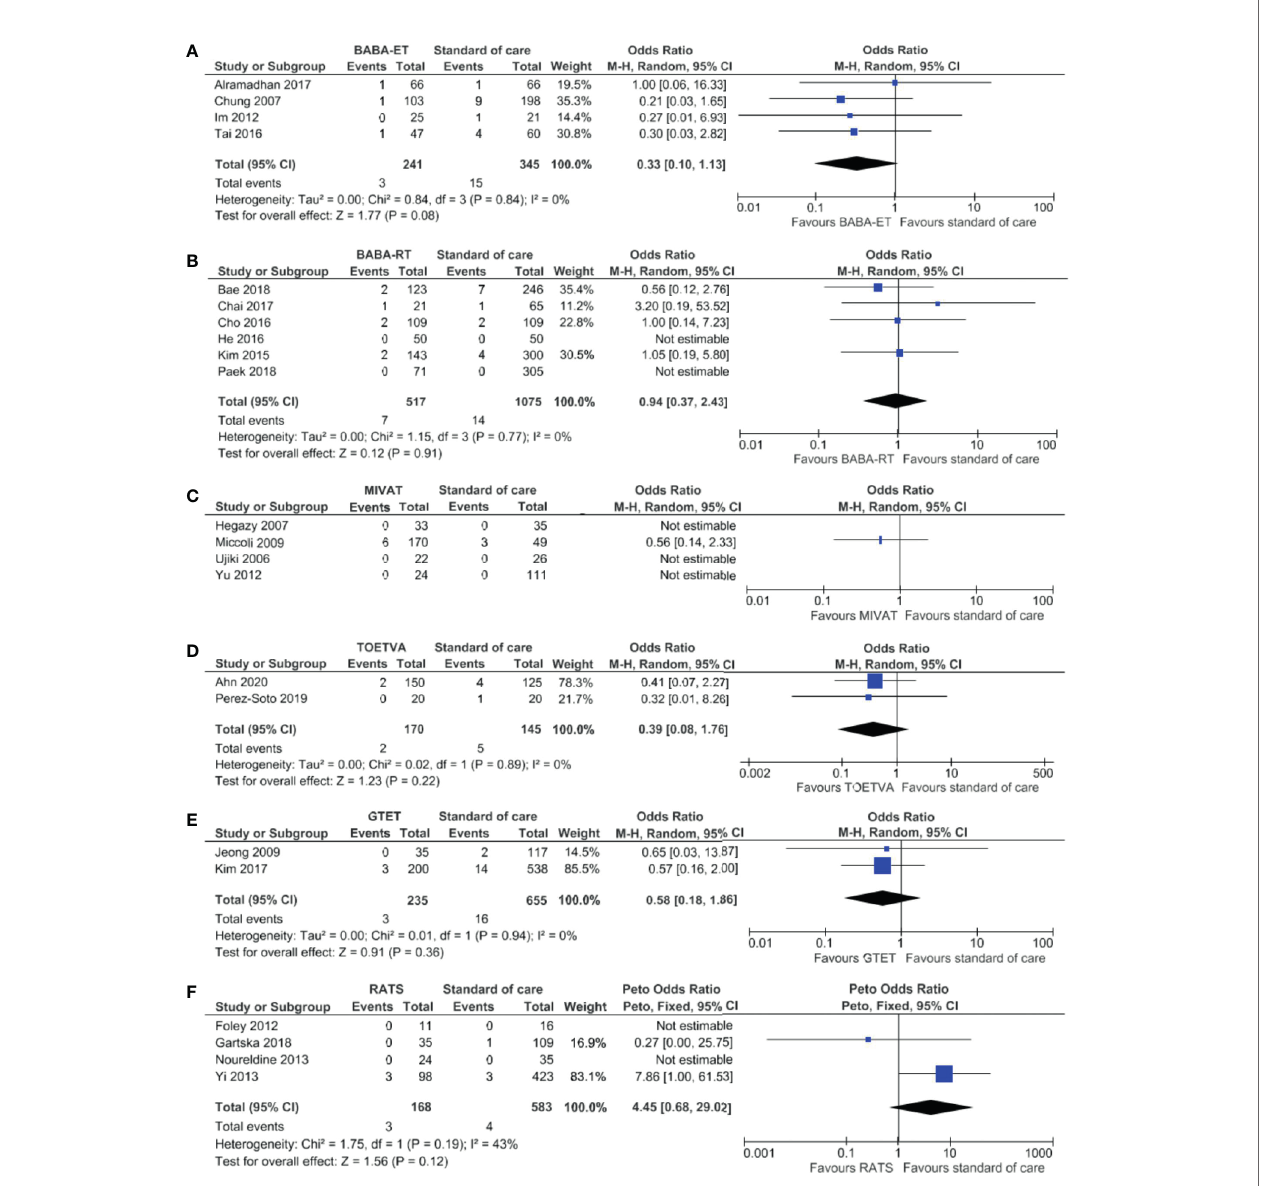
FIGURE 8 | Forests plots of permanent hypocalcemia for (A) BABA-ET, (B) BABA-RT, (C) MIVAT, (D) TOETVA, (E) GTET and (F)